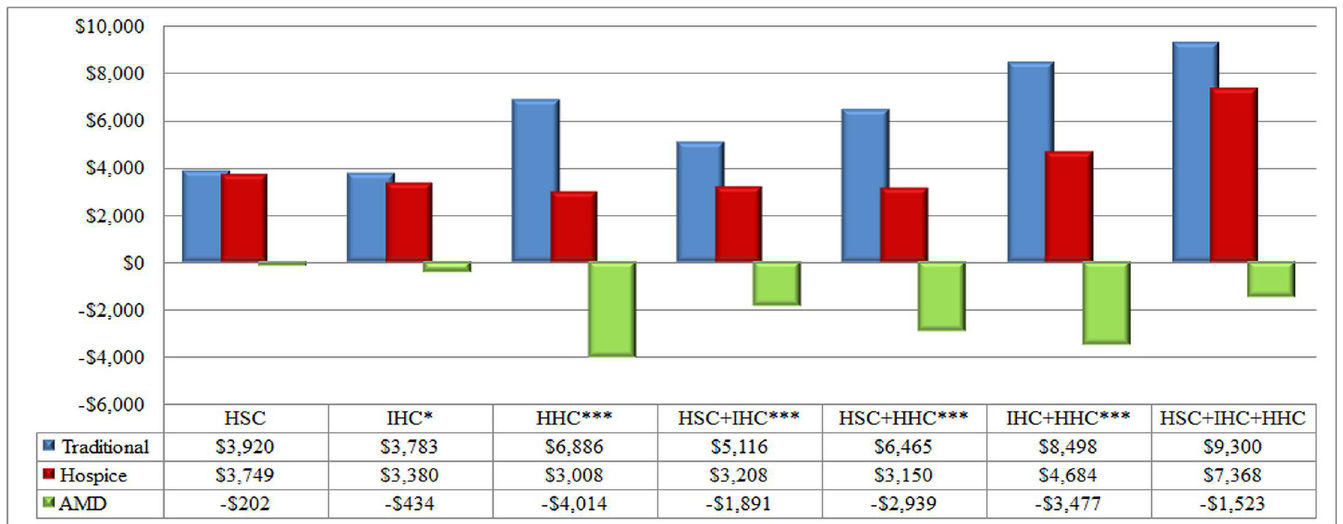
Fig 5. Total medical expenses for traditional care and various hospice care. After the average values for the traditional group and the hospice group were calculated by the least-squares means in controlling the treatment of each hospital in each year, the differences between the average values of the hospice treatment and the traditional group were the adjusted mean difference (AMDs). Negative AMD values indicate savings on medical expenses. 1 US dollar = 31 Taiwan Dollars; � p < .05;